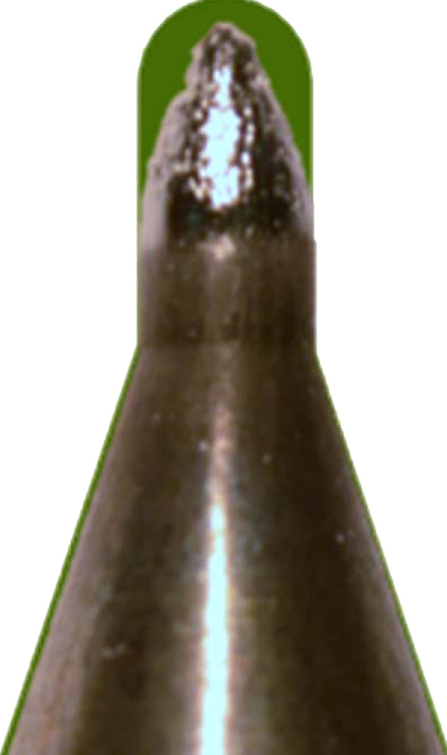
FIG. 7. A close-up photograph of a tungsten cathode after about 200 plasma injections. The width of the central tip is 2 mm and the green area highlights material erosion.